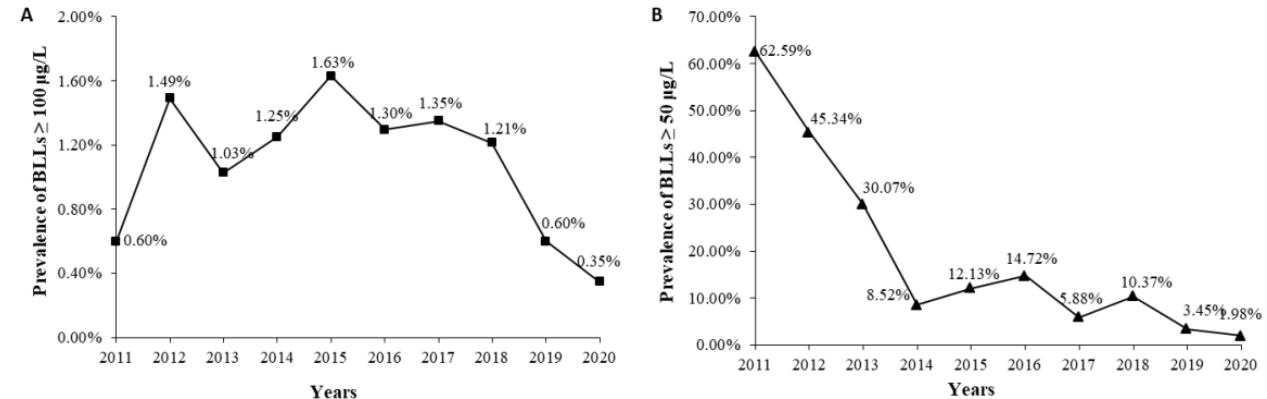
Figure 2. Prevalence of BLLs ≥ 100 μg/L ( A ) and BLLs ≥ 5 0 μg/L ( B ) from 2011 to 2020.